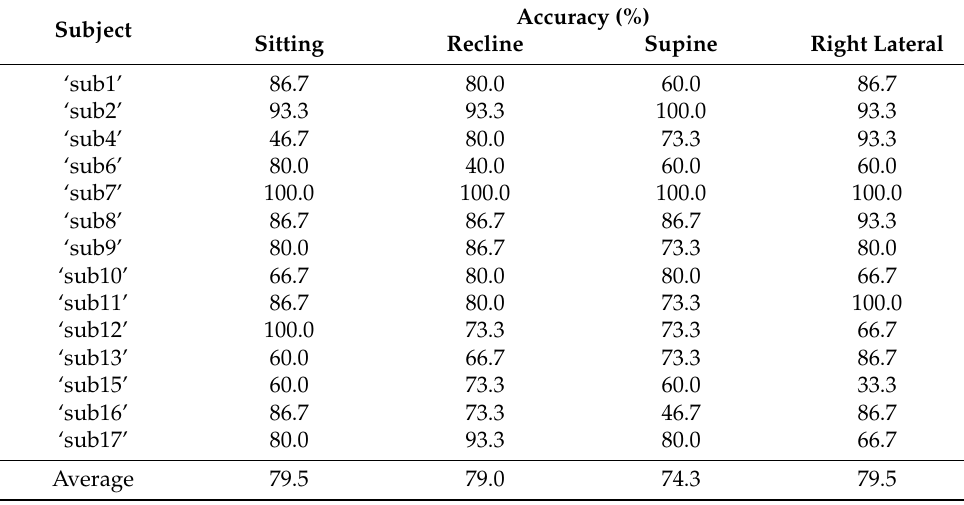
Table 1. The individual accuracy of online BCI control for each